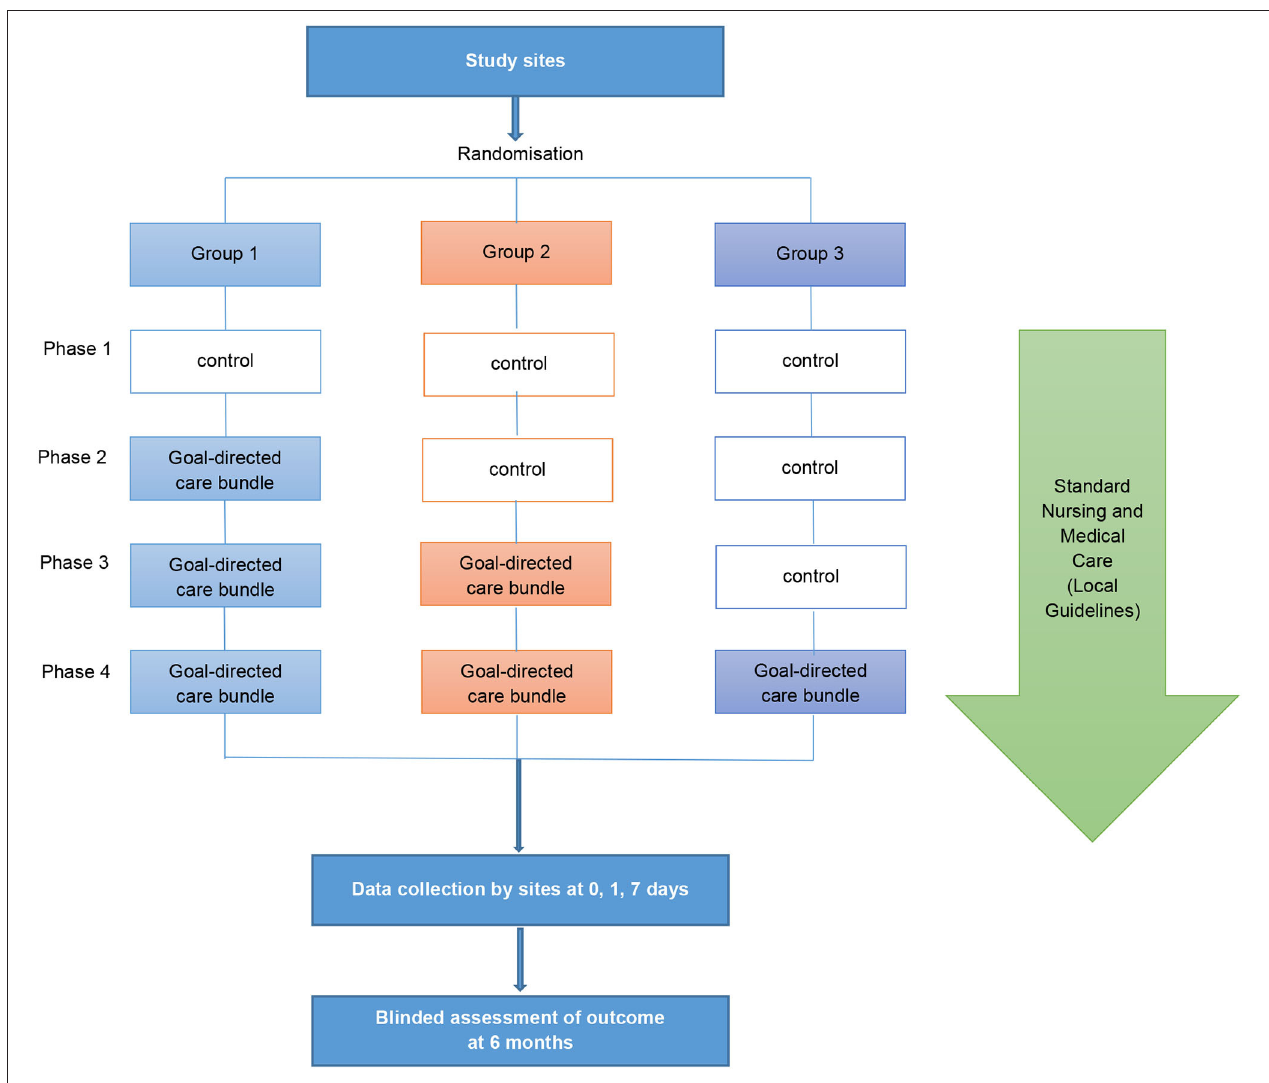
FIGURE 1 | Stepped-wedge design of